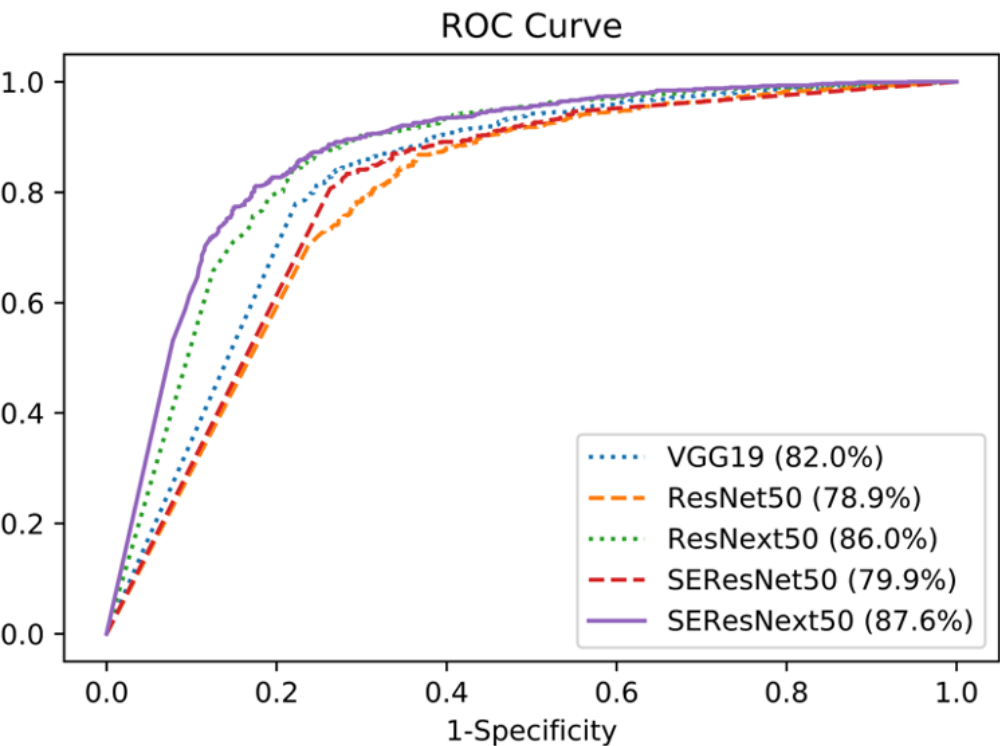
Figure 3. Receiver operating characteristic curves of each deep learning network for the internal test data set.